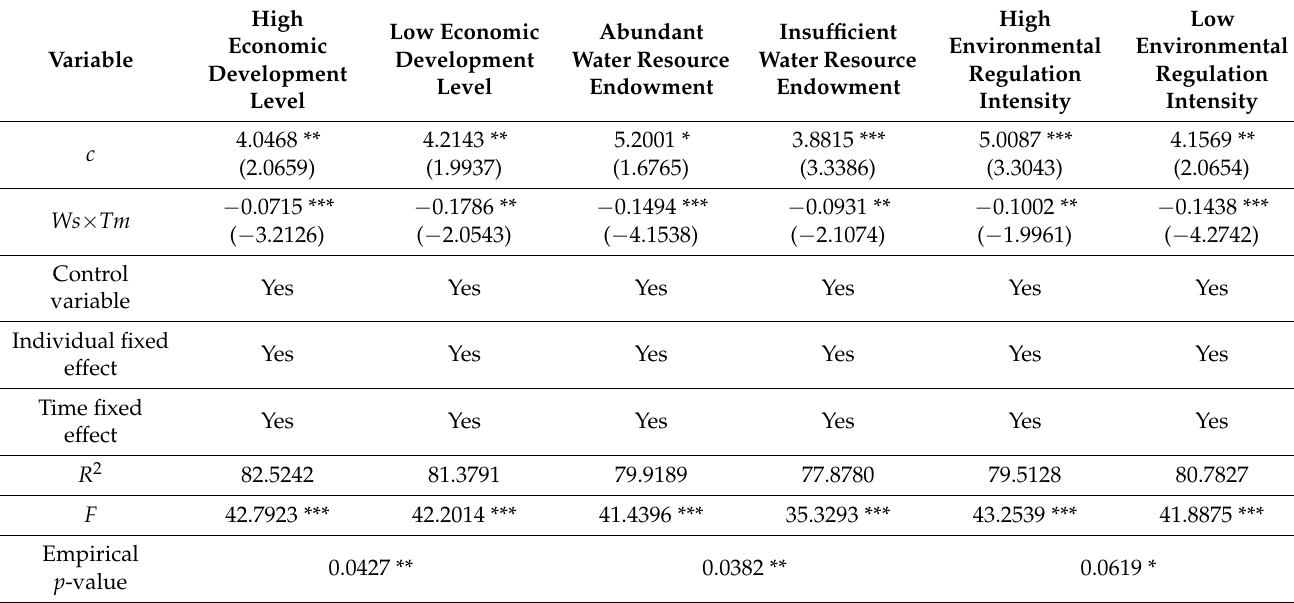
Table 8. Estimation results of regional